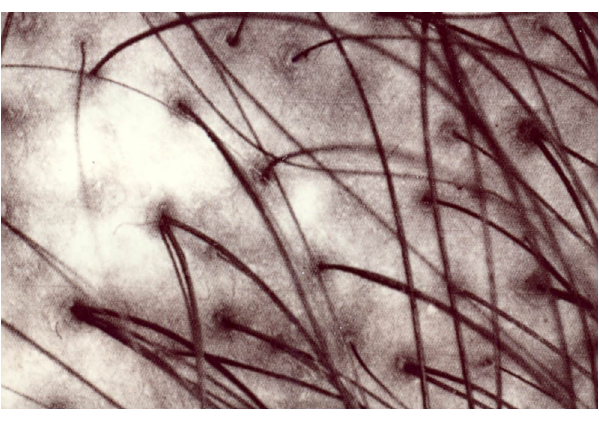
Figure 3. A man’s occipital area. A larger fuzzy amelanotic